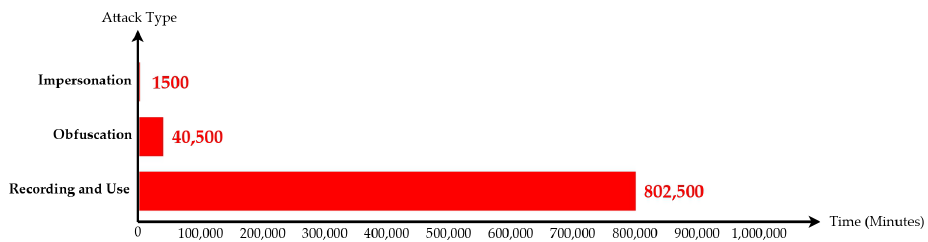
Figure 13. Since recording and use takes 802,500 min to complete signal replication and obfuscation attack takes 40,500 min, the time required is